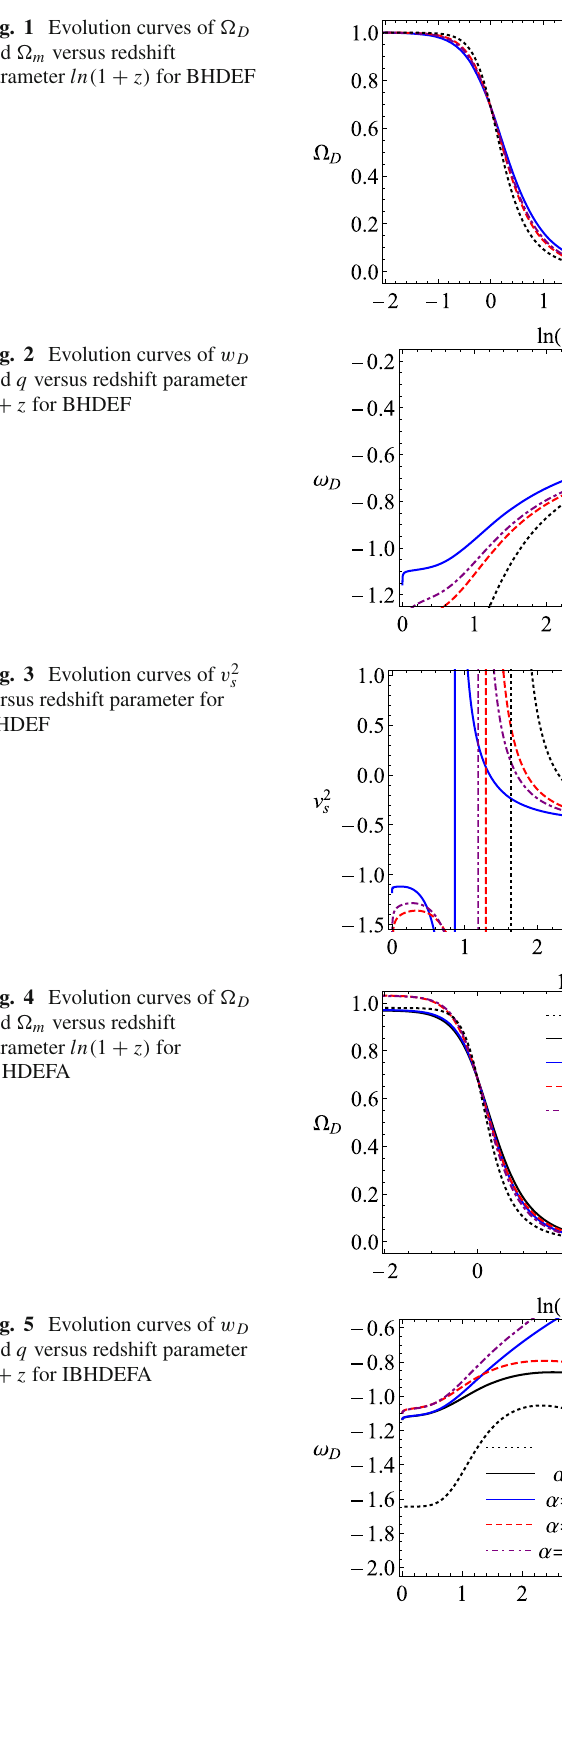
Fig. 1 Evolution curves of (cid:6) D and (cid:6) m versus redshift parameter ln ( 1 + z ) for BHDEF